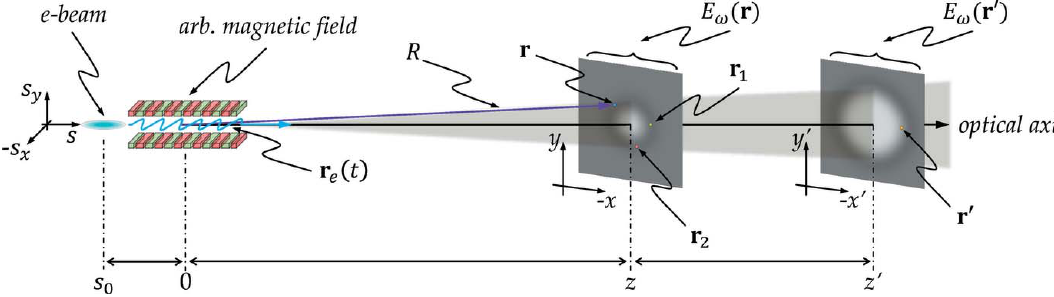
Figure 1 Spontaneous emission of relativistic electrons and propagation of wavefronts along the